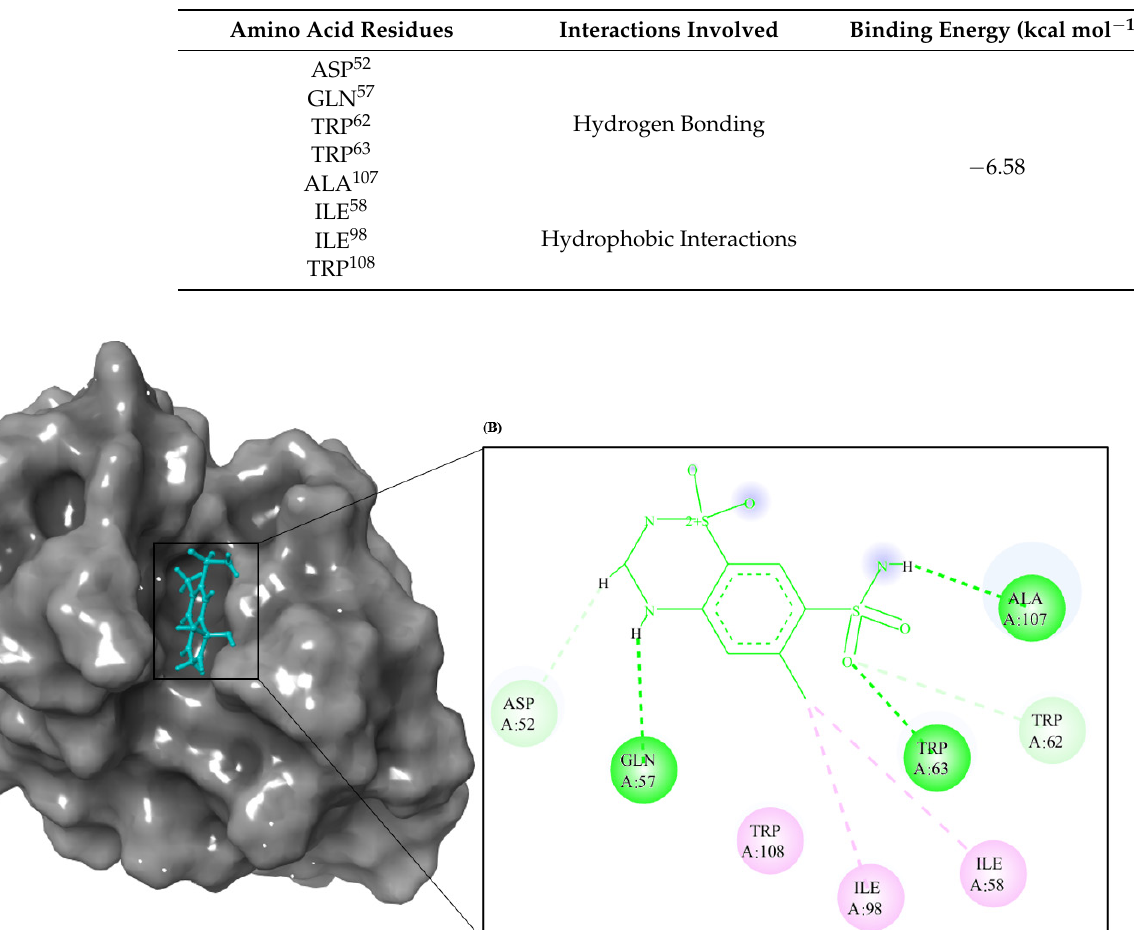
Table 2. Amino acid residues of HEWL that interact with CTZ.